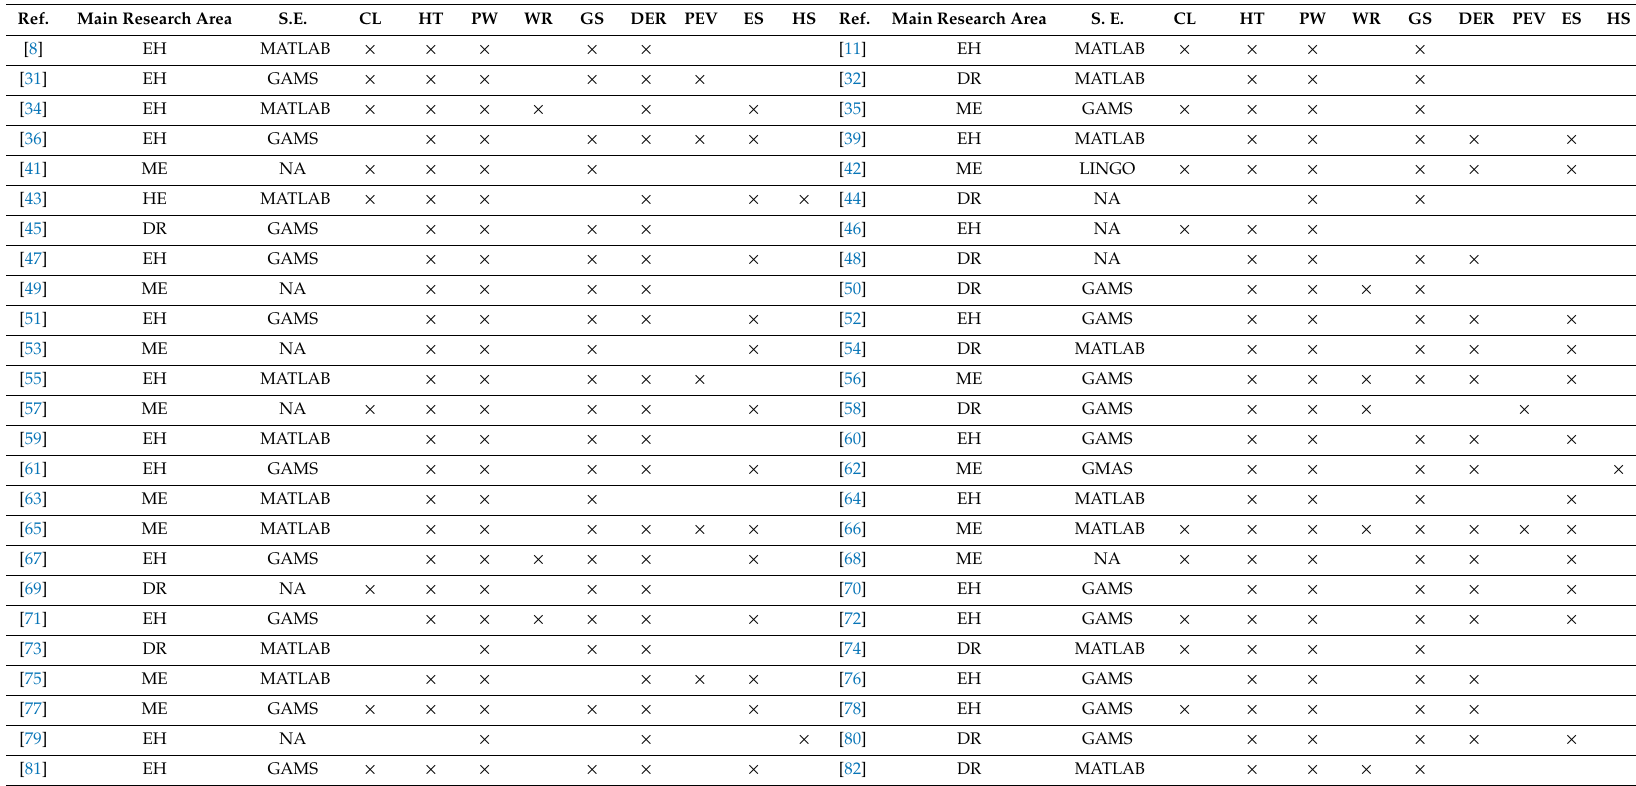
Table 1. The most recent studied